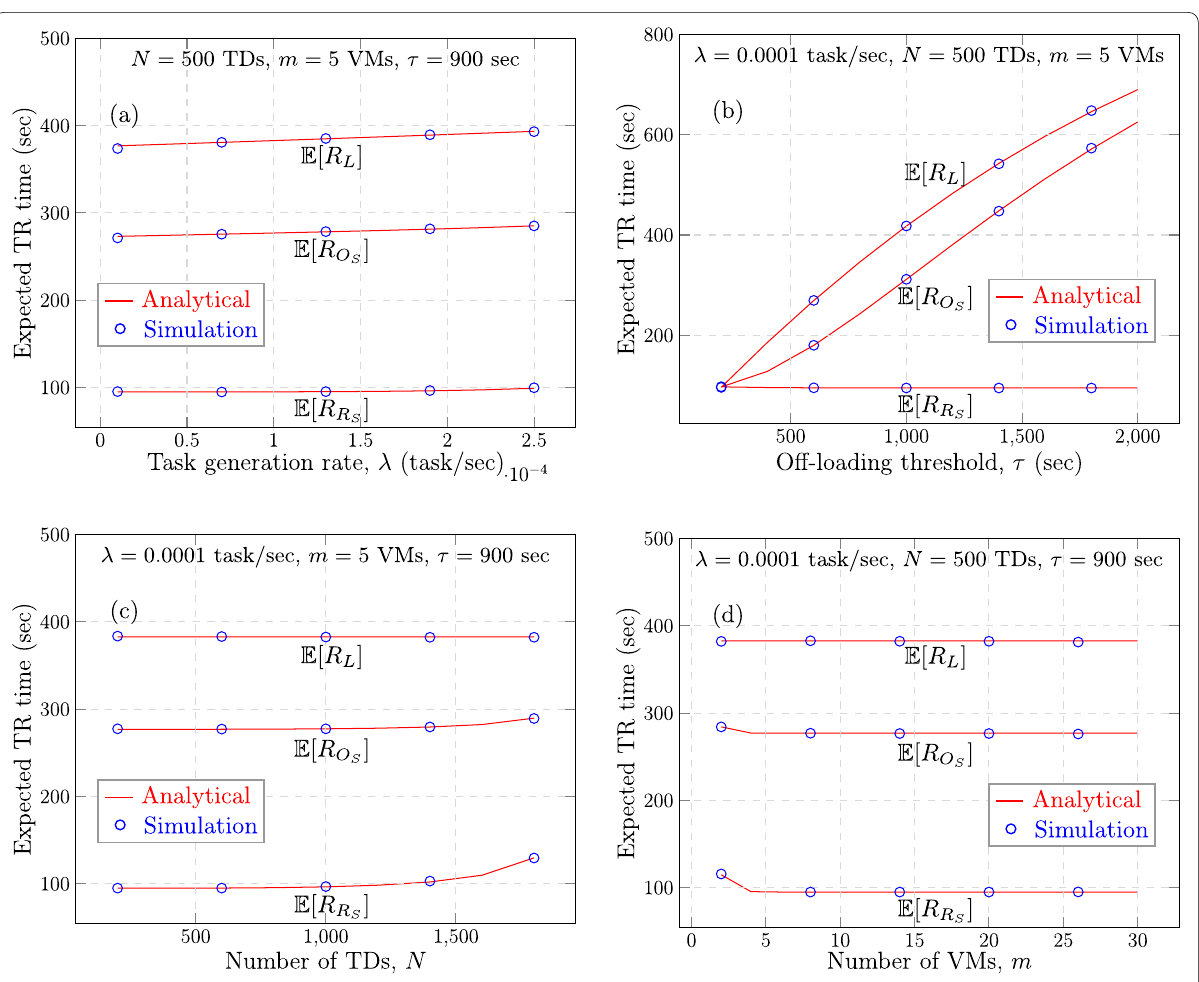
Fig. 5 TR time for the semiperfect virtualization mode, where μ inter‑generation λ . b TR time versus the off‑loading threshold τ . c TR time versus the number of TDs N . d TR time versus the number of VMs